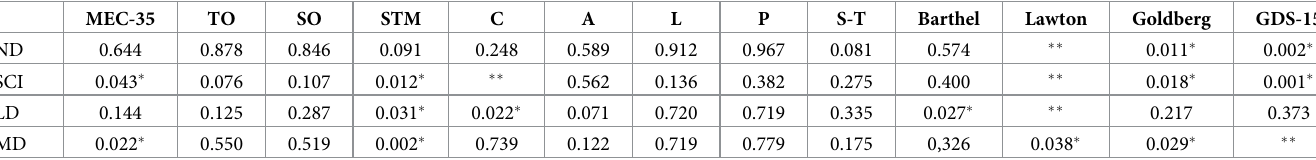
This study explored the neuropsychological constructs, functionality, and mood according to the cognitive level in four groups of older adults attending a primary healthcare center in Spain. We have shown that older adults in the continuum without cognitive impairment had poorer performance on the neurological constructs of STM, A, and TO, as compared to the moderate cognitive impairment group. Therefore, it would be interesting to personalize CS- based therapeutic interventions, adapting them to the participants’ specific cognitive level. Table 3a 1 . By levels, the p-value of the mean differences test between the quantitative variables by gender. MEC-35 TO SO STM C A